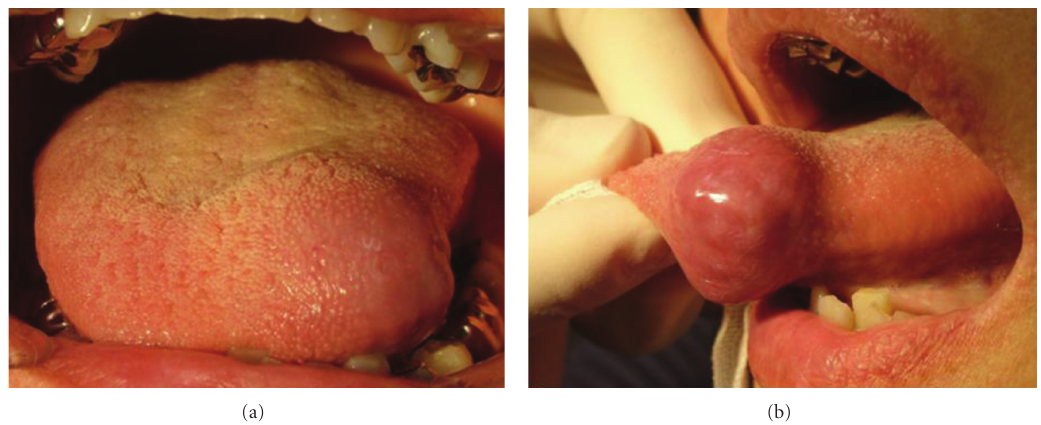
Figure 1: Clinical appearance of the lingual tumor. The mass is dome shaped with a dark violet-colored surface.